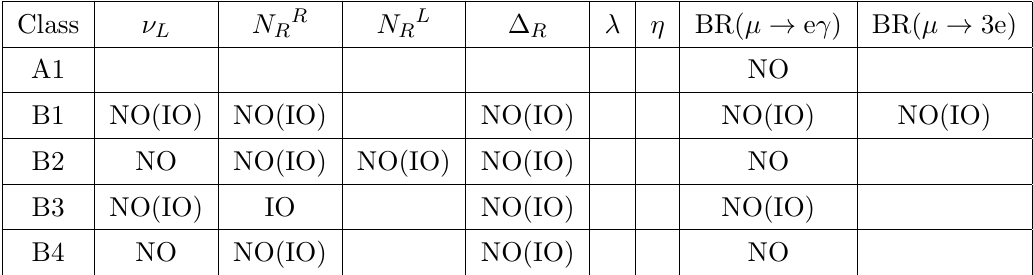
Table 6 . Summarised form of the results only for the allowed cases pointing out the individual contributions to NDBD as well as the total CLFV contributions which can saturate corresponding experimental upper limits for both NO and IO. The empty boxes correspond to the contributions which remain subdominant.